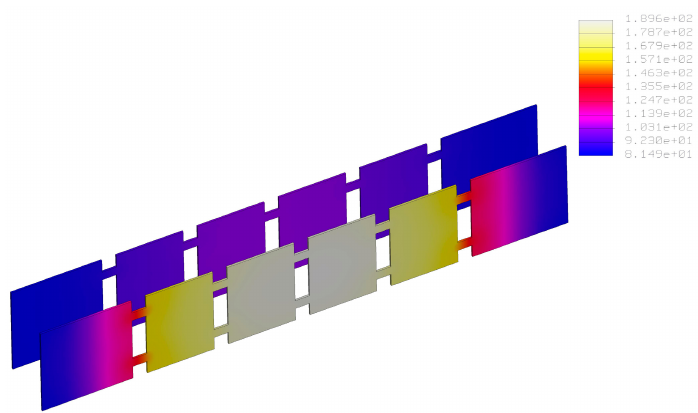
Figure 7. Temperature distribution only for both fuselinks.